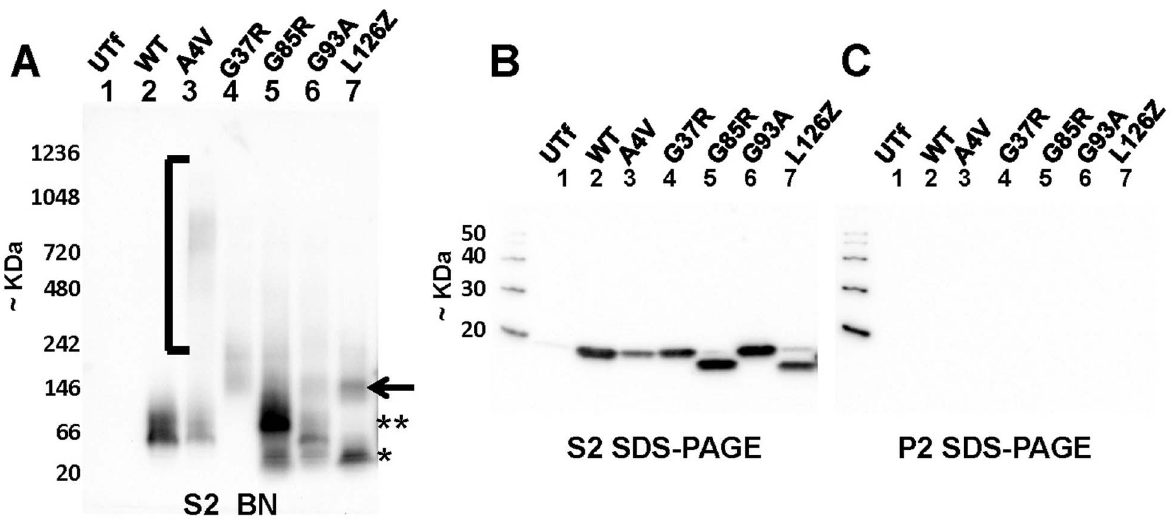
Figure 2. Immunoblots of BN-gels analyzing the electrophoretic mobility of WT and mutant SOD1. As described in Methods and diagrammed in Fig. 1, HEK293FT cells were transiently transfected with vectors to express WT or mutant SOD1. 24 hours post-transfection, the cells were lysed in digitonin and then soluble fractions were subjected to high speed centrifugation to generate an S2 soluble fraction and a P2 pellet fraction. ( A ) 16 m l of S2 soluble fraction was analyzed by BNGE and immunoblotting with hSOD1 antibody (which recognizes aa 24–36 of human SOD1 [32]). In this experiment, the PDVF membrane was air dried to fix proteins to the membrane. ( B and C ) To estimate loading and assess the level of large aggregates in the S1 fractions, 16 m l of the soluble fraction and 1/10 of total P2 fraction (roughly equivalent volumetrically to what is analyzed for the S2 fraction) were analyzed by SDS-PAGE and immunoblotting with the hSOD1 antibody. The membranes for each of the SDS-PAGE blots were incubated with primary and secondary antibodies in parallel (antibody dilutions prepared from the same stock and portioned out from a single mixture) and imaged simultaneously. The images shown are representative of at least 3 independent replications.